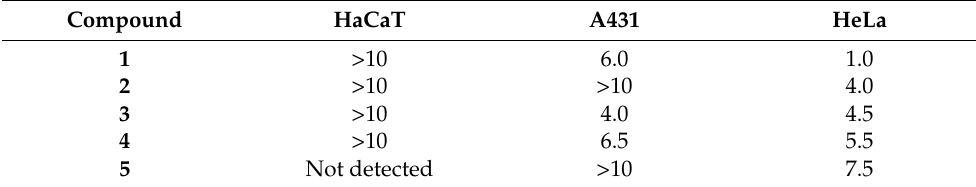
Table 1. Cytotoxic activities of metabolites 1 – 5 . Compounds IC 50 ( µ M) 1